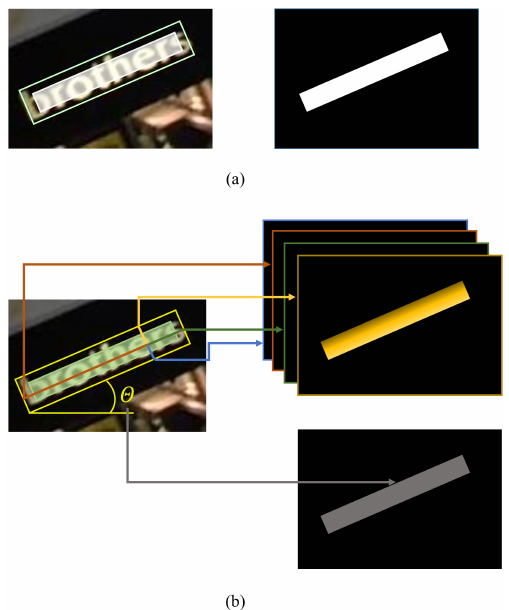
Figure 5. The process of ground truth generation. ( a ) Score map generation by shrinking the word boxes. ( b ) RBOX generation based on the distance from the given pixel to the four